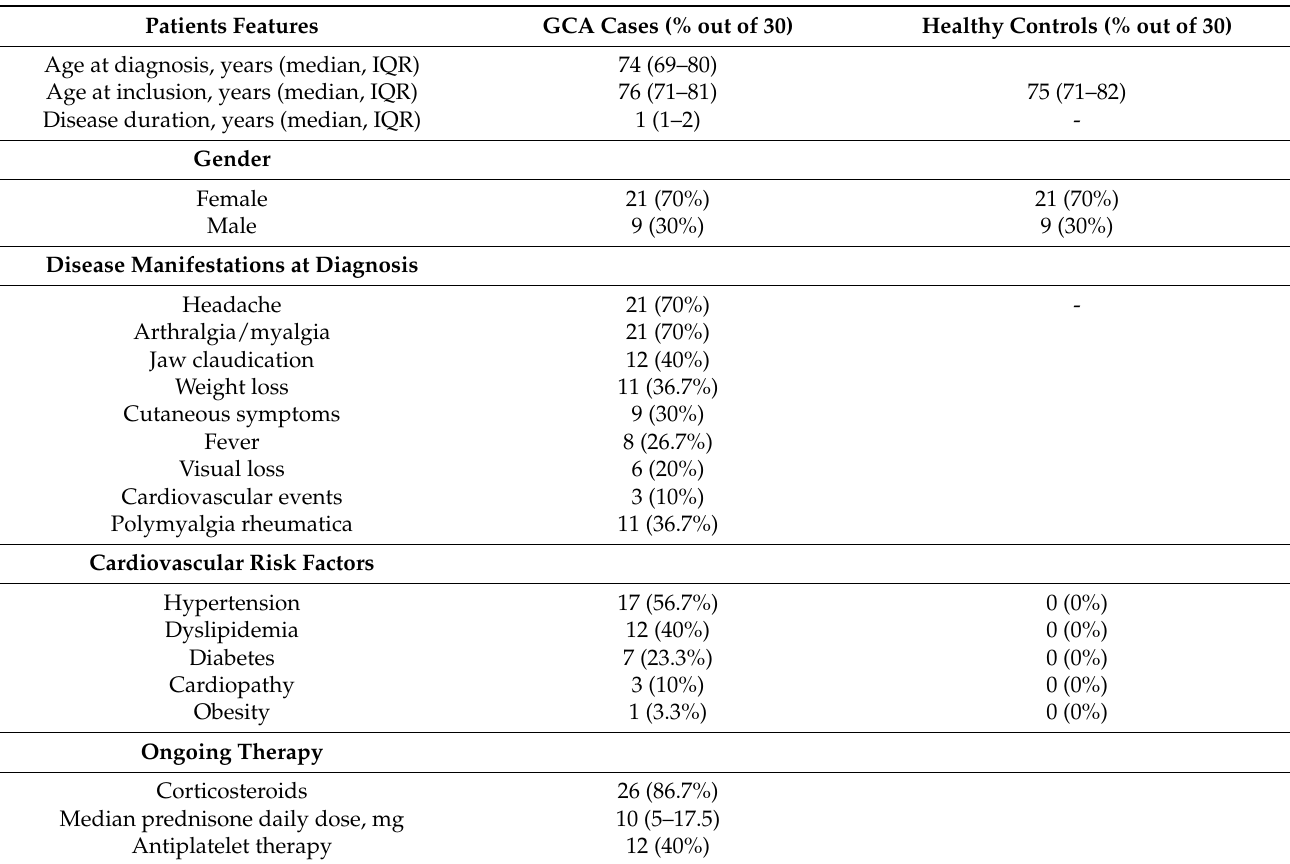
Table 1. Clinical characteristics of the GCA patients and matched healthy controls enrolled in the study. Patients